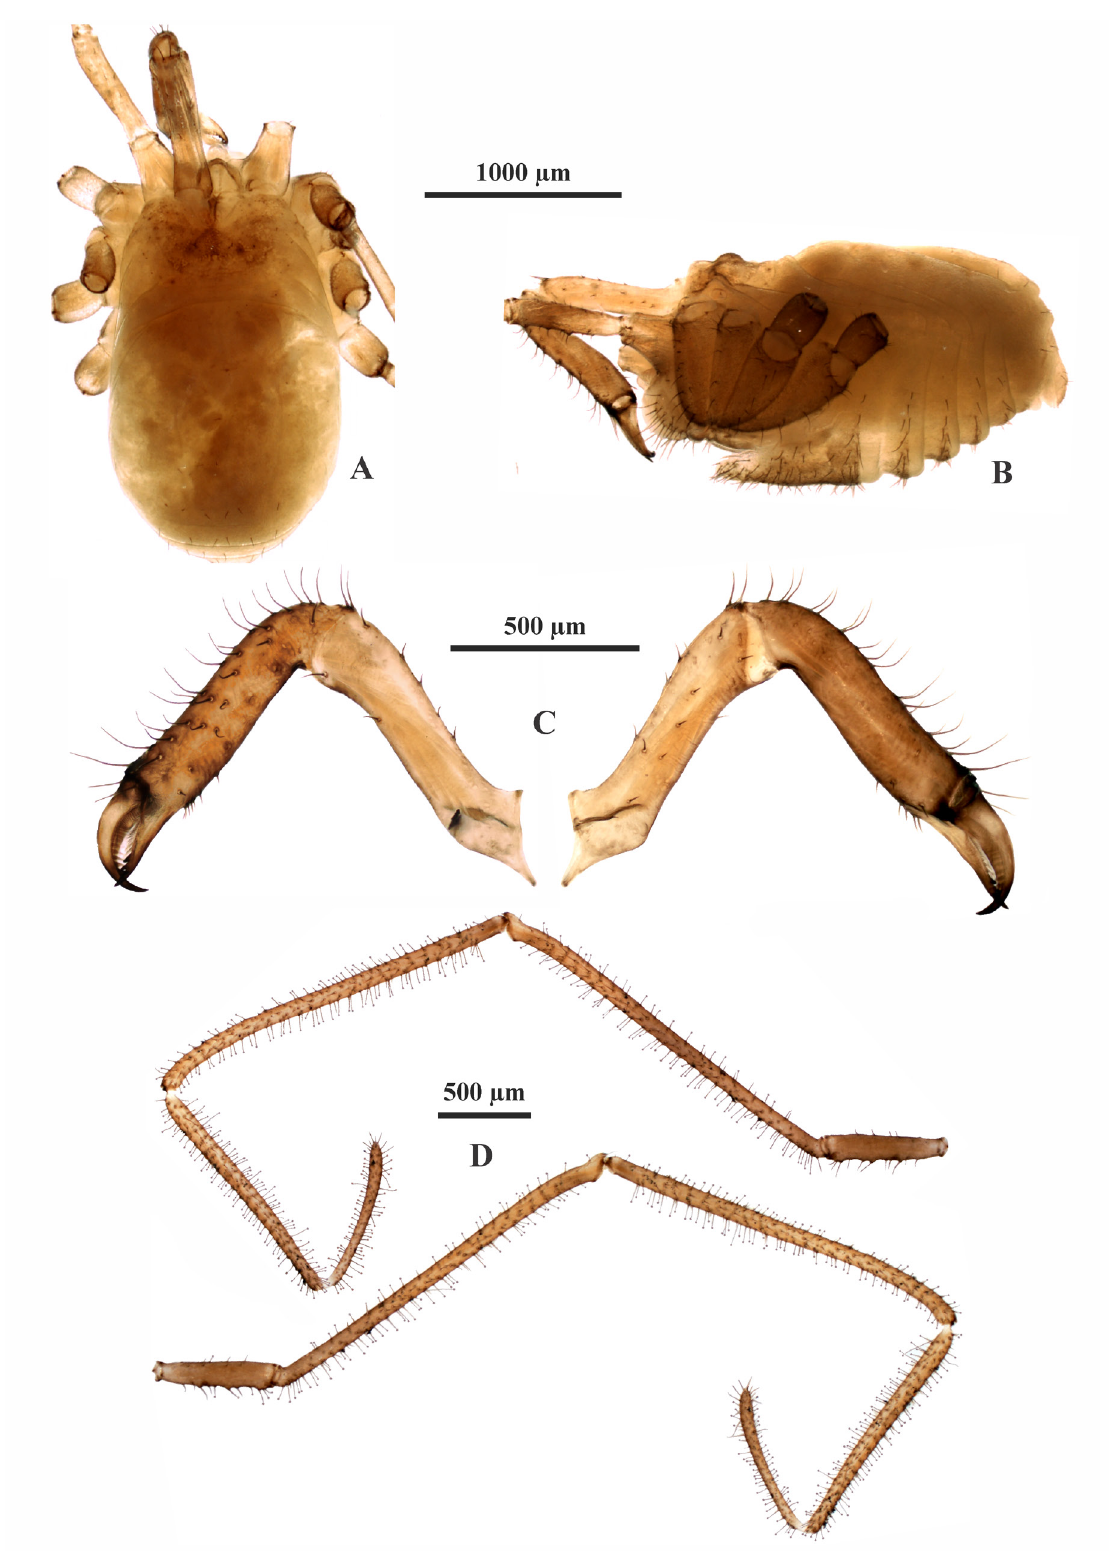
Fig. 4. Nemaspela borkoae sp. nov., ♀, allotype (PMSL-Opiliones-PK&TN 7/2019). A – B . Body, dorsal and lateral views (dry preparation). C . Right chelicera, medial (left) and lateral (right) views. D . Right pedipalp, medial (upper) and lateral (lower)